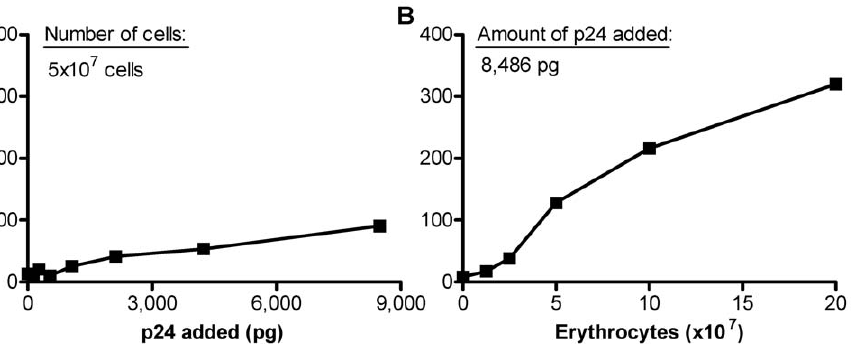
Figure 1. Binding of a HIV-1 isolate to erythrocytes. (A) Increasing amounts of HIV-1 isolate 90US_873 (as quantified by p24) were incubated with 5 6 10 7 erythrocytes (donor Q6), and binding of p24 to the cells was determined. (B) Dose-dependent binding of the HIV-1 isolate (8,486 pg p24) with increasing numbers of erythrocytes. The experiment shown is representative of 3 separate experiments. In each experiment HIV-1 was bound to erythrocytes in triplicate, washed, and the triplicates were pooled for p24